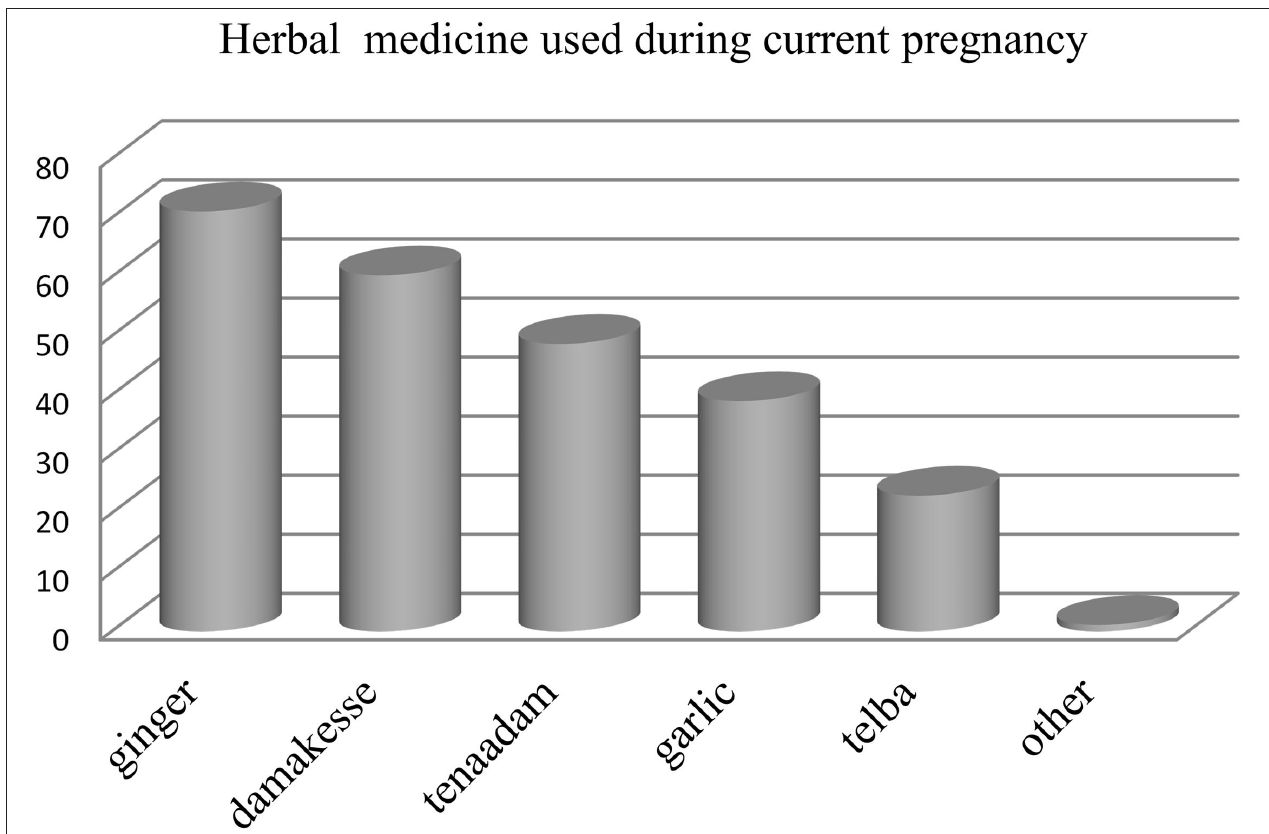
FIGURE 3 | Type’s herbal medicine used during current pregnancy at governmental health institutions in Debre Brehan town, Ethiopia.